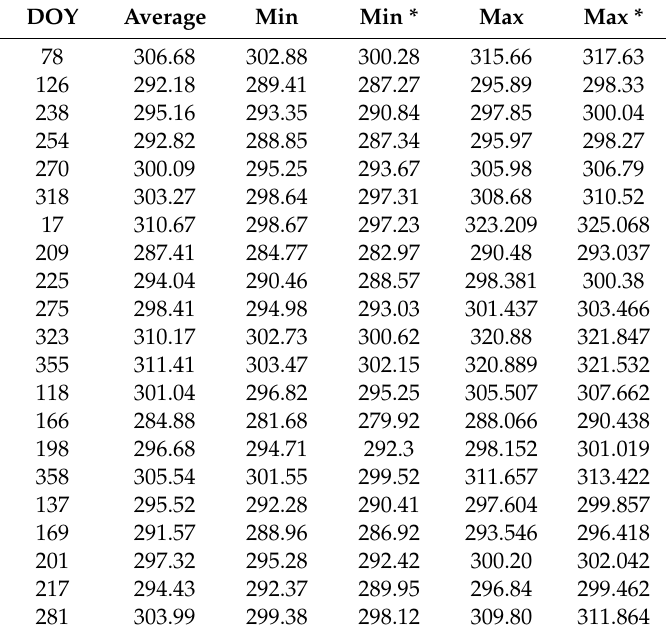
Table 4. Land Surface Temperature stats of the